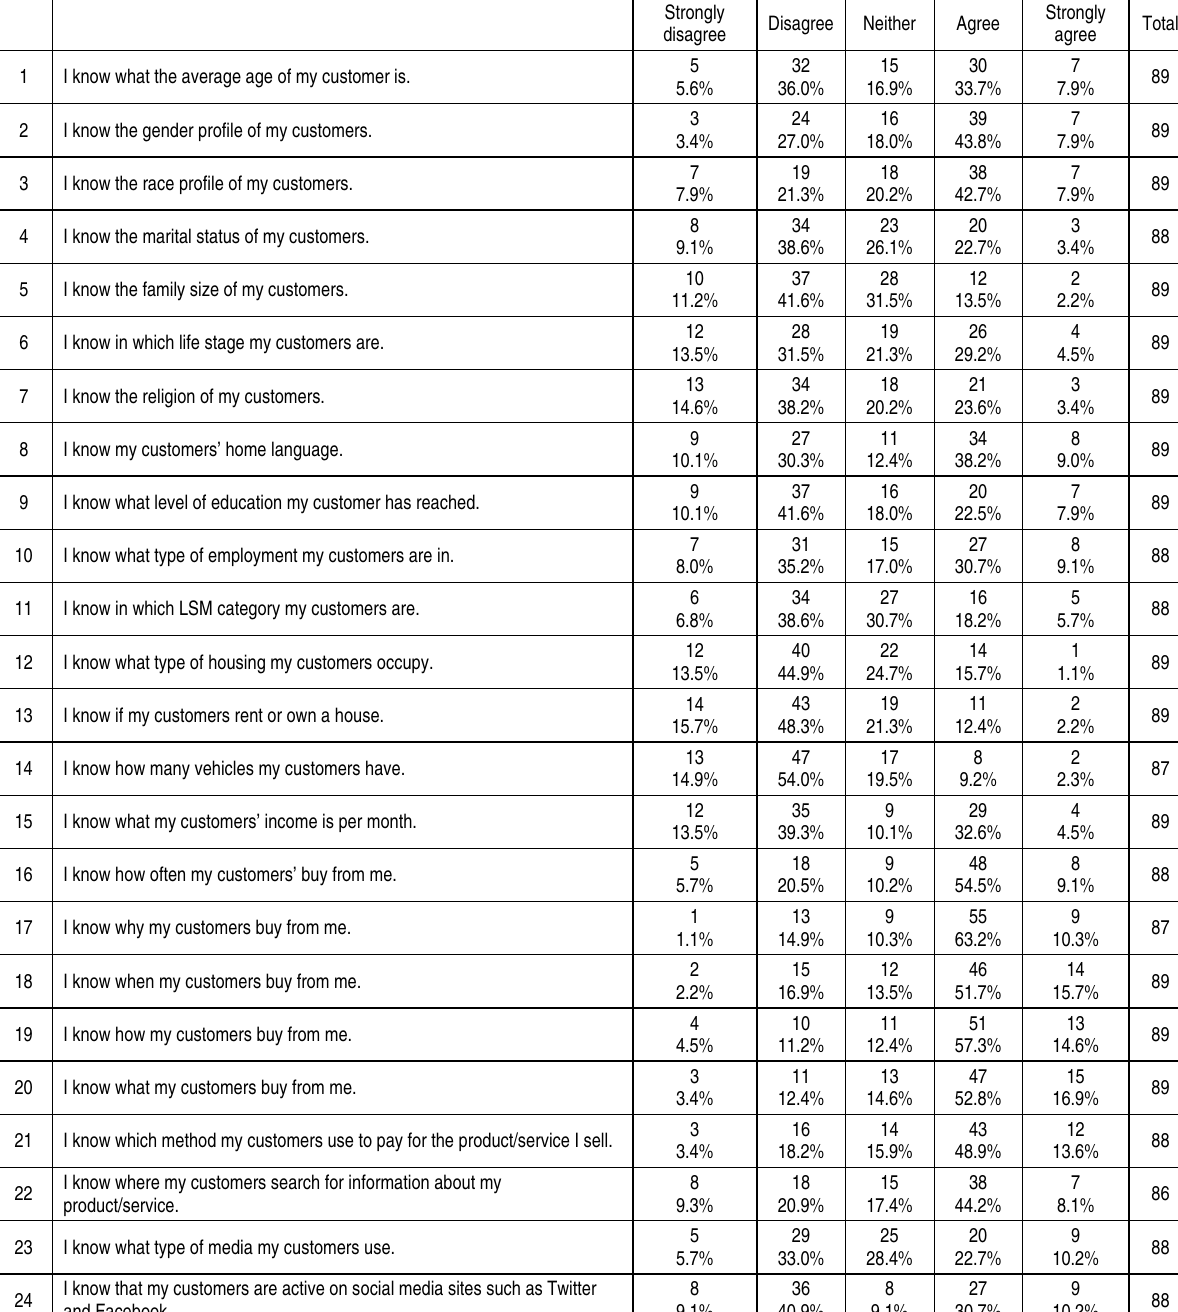
Table 1. Distribution of responses on customer knowledge statements